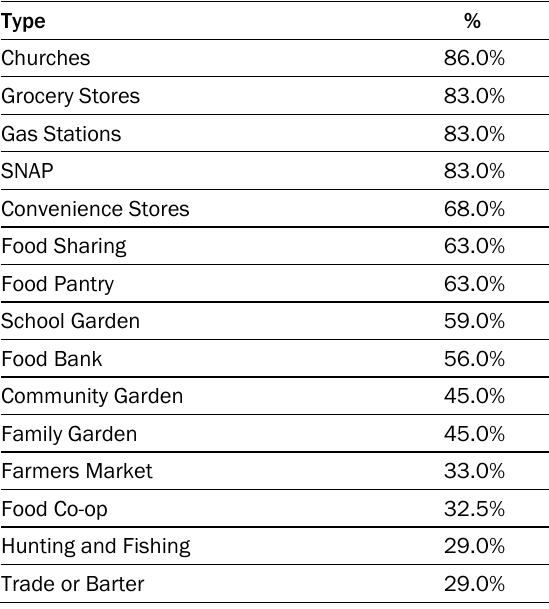
Table 1. Percentages of Food Procurement